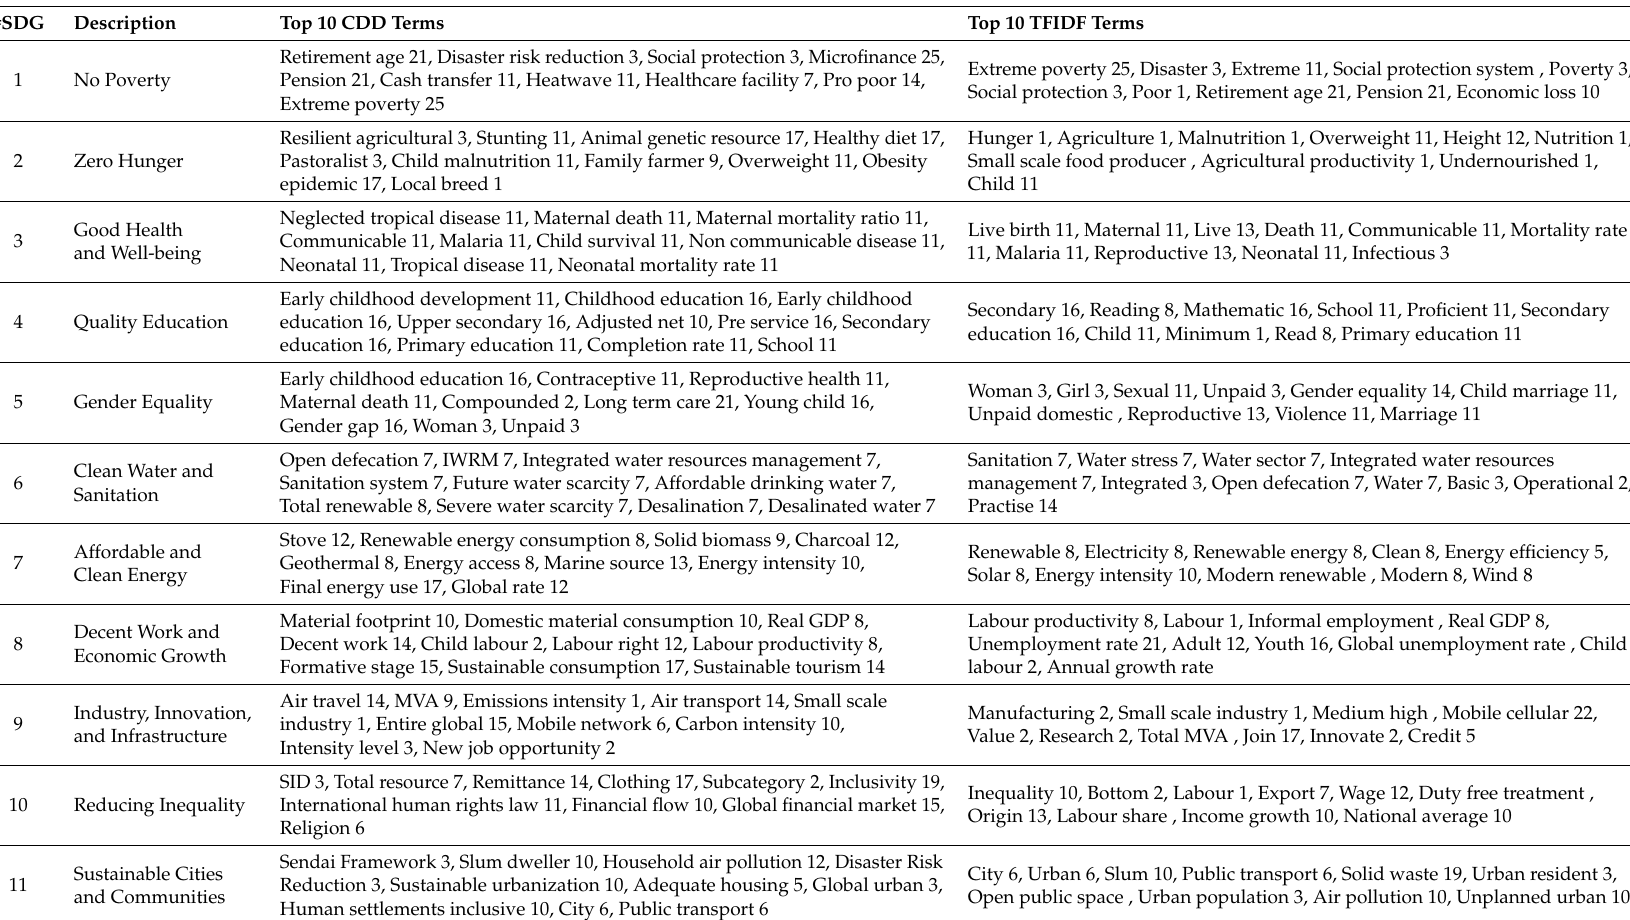
Table 4. The top 10 CDD terms and TFIDF terms for each